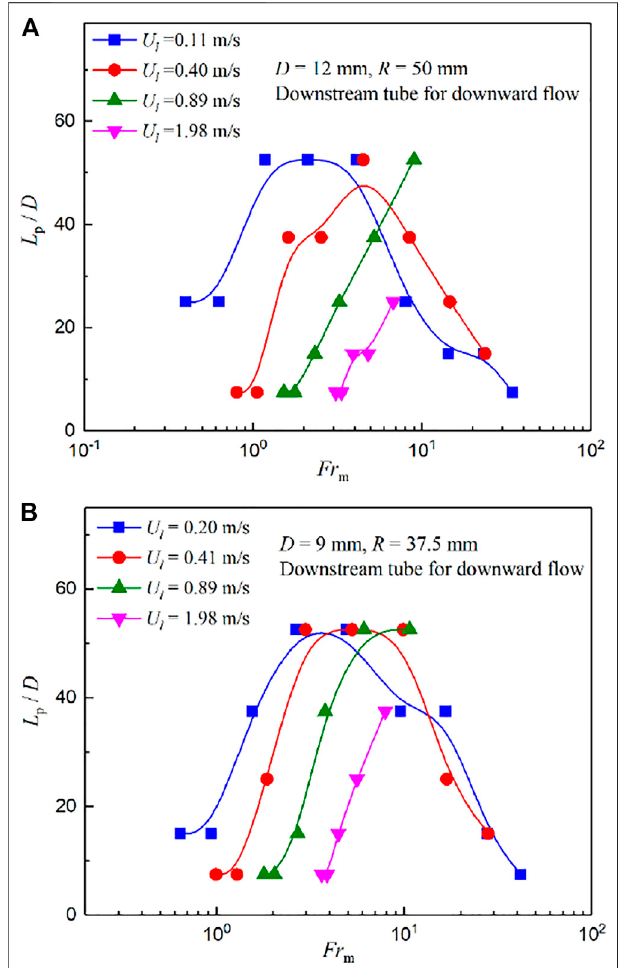
FIGURE8| EffectofthemixedFroudenumber Fr m onthedimensionless perturbation length L p / D . (A) Downstream tube for downward fl ow, D = 12 mm, R = 50 mm and (B) Downstream tube for downward fl ow, D = 9 mm, R = 37.5 mm.